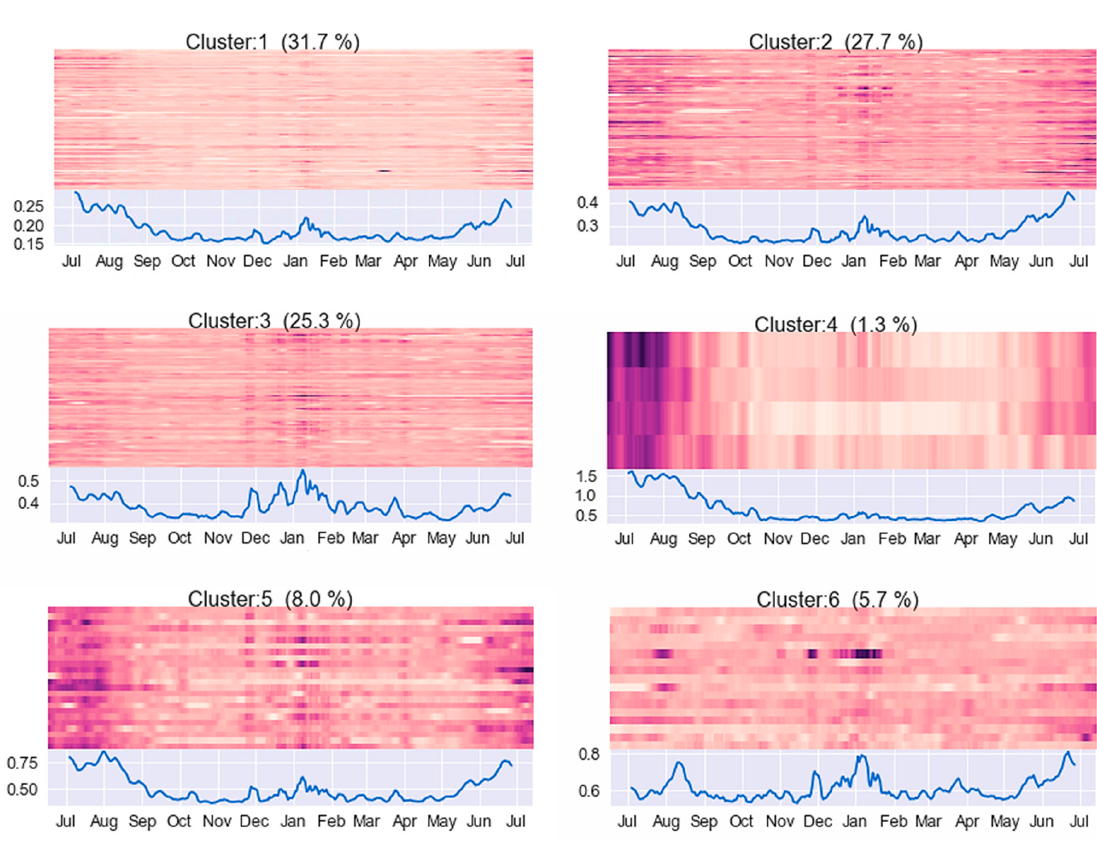
Figure 10. Heat map of electricity demand.